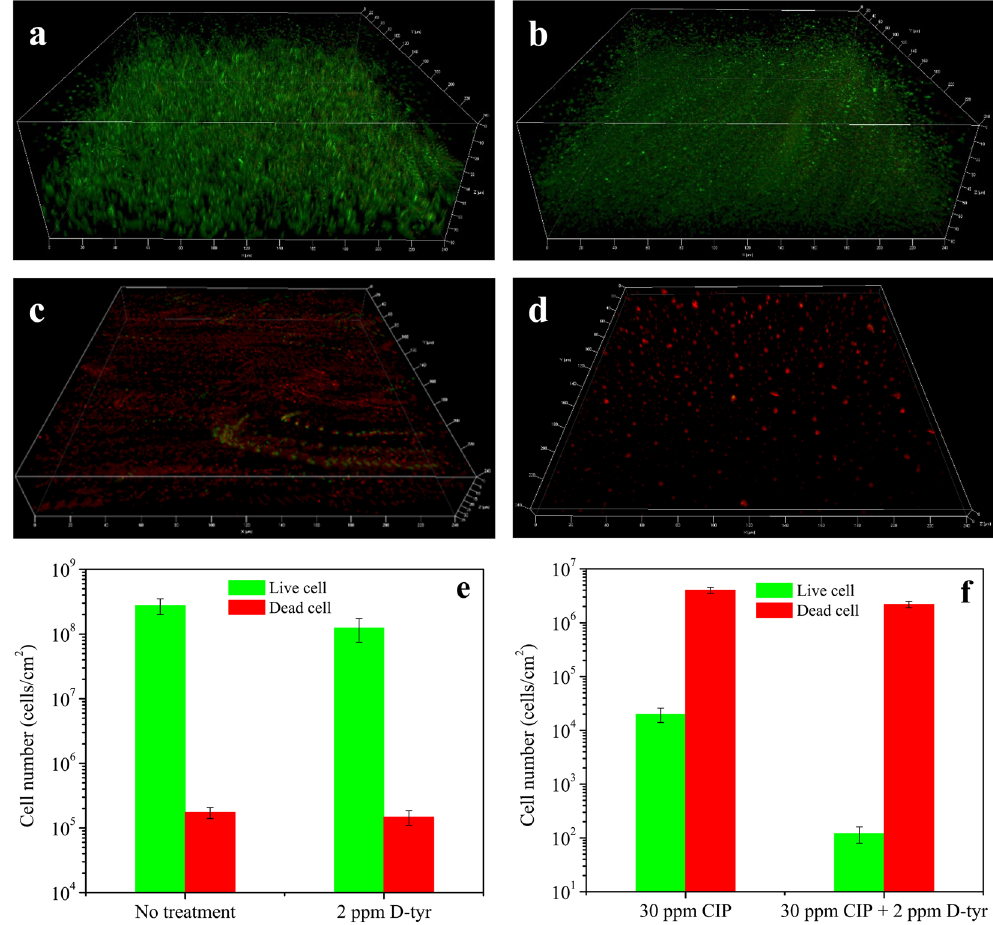
Figure 3. CLSM images of PA biofilms (Dimensions: X = 224 µ m, Y = 224 µ m) on C1018 after the 7-day biofilm prevention test with: ( a ) no treatment (control) (biofilm thickness = 76 µ m), ( b ) 2 ppm D-tyr (biofilm thickness = 74 µ m), ( c ) 30 ppm CIP (biofilm thickness = 34 µ m), and ( d ) 30 ppm CIP + 2 ppm D-tyr (biofilm thickness = 10 µ m). The calculated numbers of live/dead cells are shown in ( e ) and ( f ). (Error bars represent standard deviations, statistical reference point n =